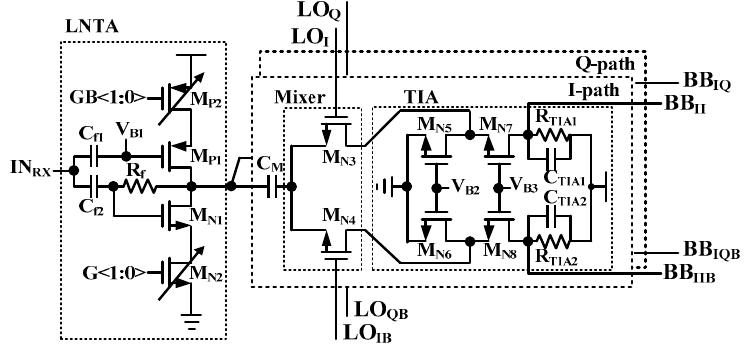
Figure 2. Schematic of RF-FE with 25% duty-cycle current-driven passive mixers.